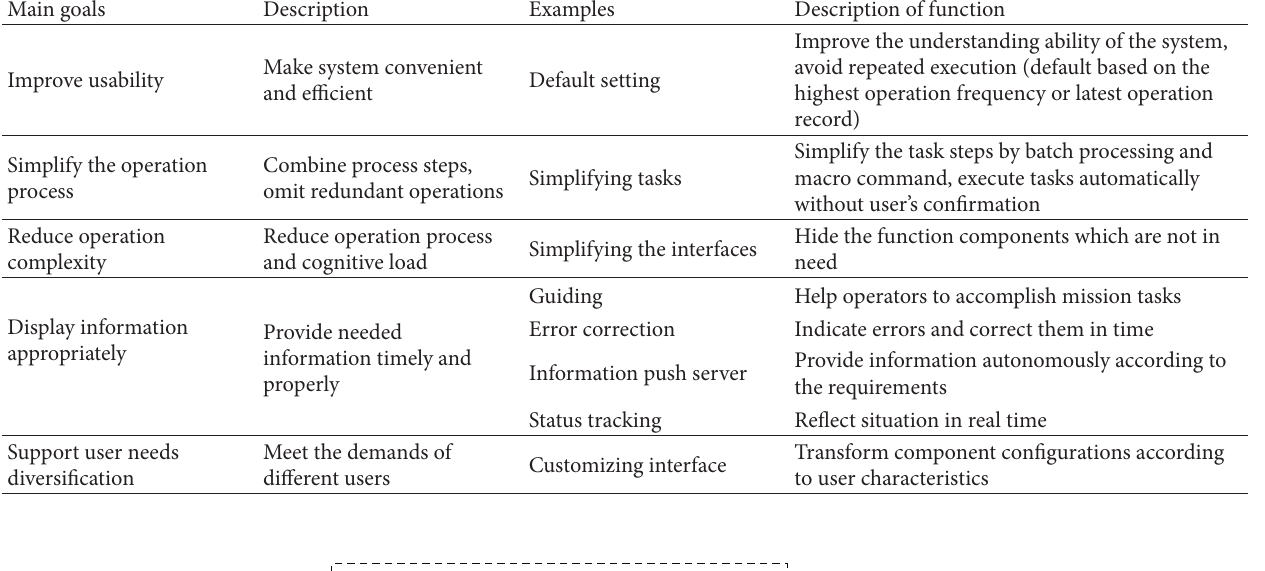
Table 1: Goals and functions of AHCI for the PT operation platform.